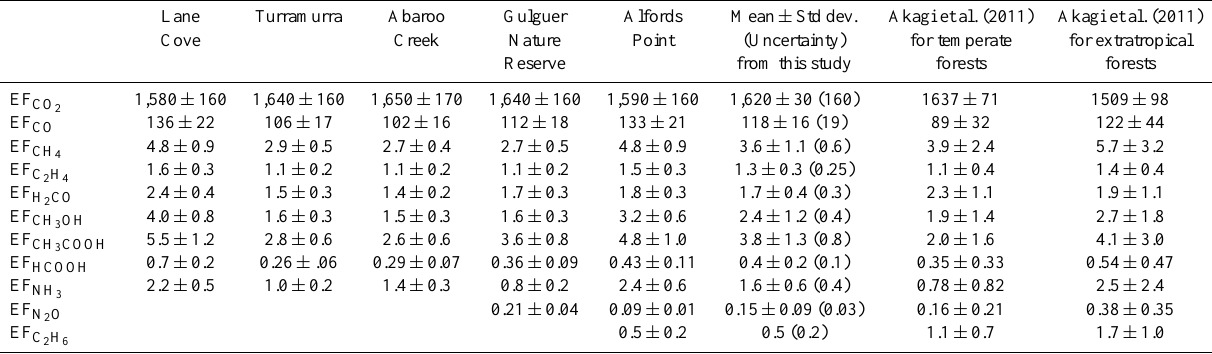
Table 4. Emission factors (EF gas ) in gkg − 1 and uncertainties for each fire along with the mean and standard deviation of the emission factors from all of the fires sampled. The measurement uncertainty in the mean result is shown in parentheses. Lane Turramurra Abaroo Gulguer Alfords Mean ± Std dev. Akagi et al. (2011) Akagi et al. (2011) Cove Creek Nature Point (Uncertainty) for temperate for extratropical Reserve from this study forests